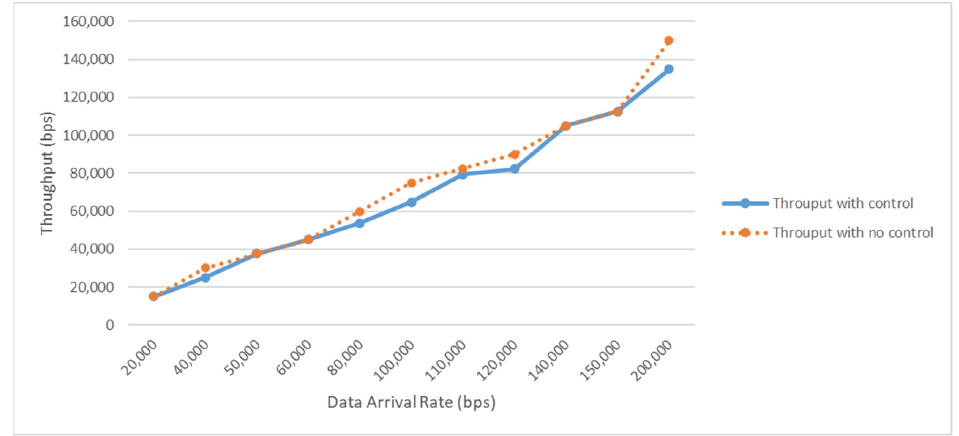
Figure 10. Network throughput.